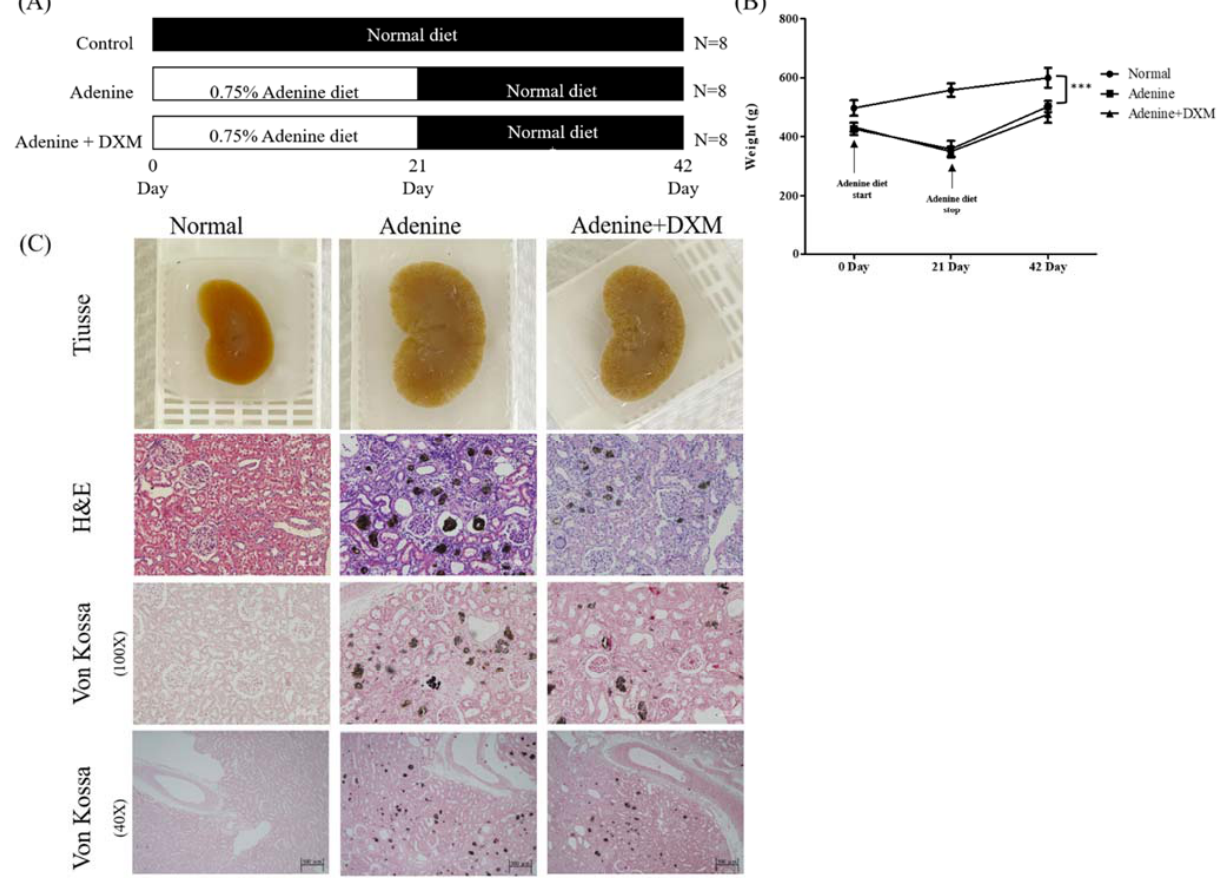
Figure 4. Effects of DXM in a rat model of chronic kidney disease (CKD; n = 8). ( A ) In vivo experimental design and DXM treatment schedule. ( B ) Quantification of weights of rats administered DXM orally. Not significant: ns, *** p < 0. 001. ( C ) Paraffin tissue sections of kidney, hematoxylin–eosin staining of kidney (magnification, × 100), and von Kossa staining of kidney (magnification, × 100 and ×